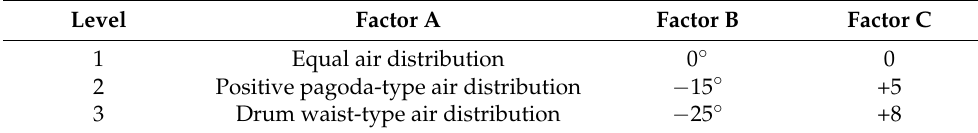
Table 4. Orthogonal test factors and levels.